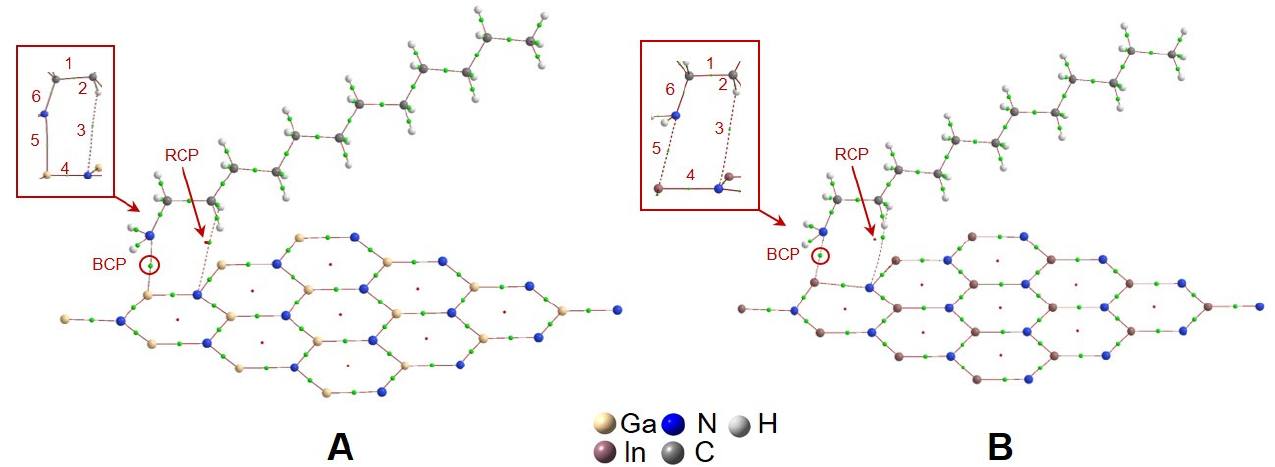
Figure 5. QTAIM analysis for GaN-DDA ( A ) and InN-DDA ( B ) systems.